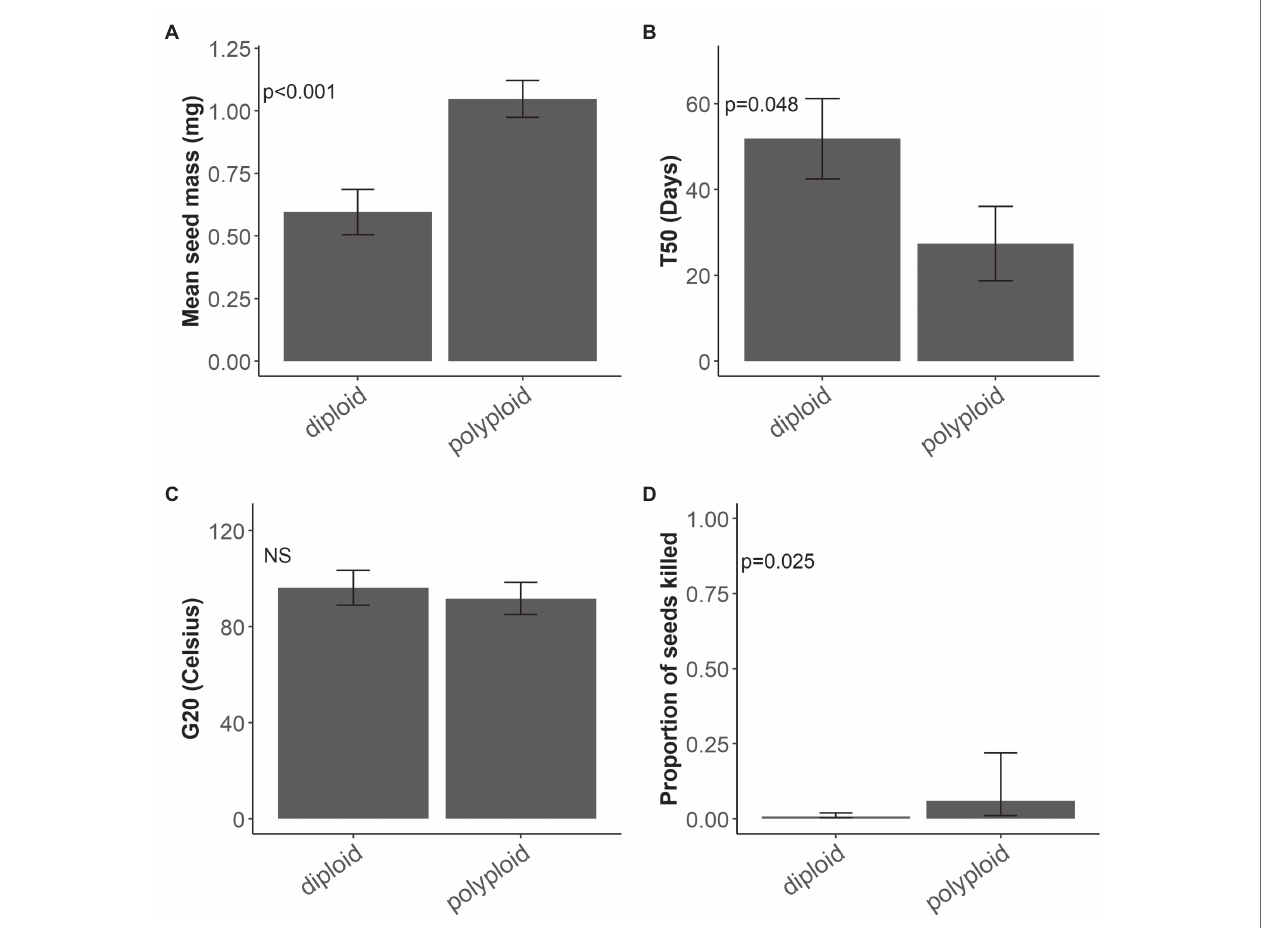
FIGURE 1 | Ploidy and seed traits. Mean and standard error for (A) seed mass (mg; n = 20 per species), (B) germination speed T 50 (days; n = 4 per species), (C) minimum dormancy-breaking temperature thresholds G 20 ( ° C; n = 4 per species) and mean and confidence interval for (D) seed mortality (proportion of seeds killed) at 120 ° C treatment, of diploid and polyploid Pomaderris ( n = 4 per species). NS indicates a non-significant